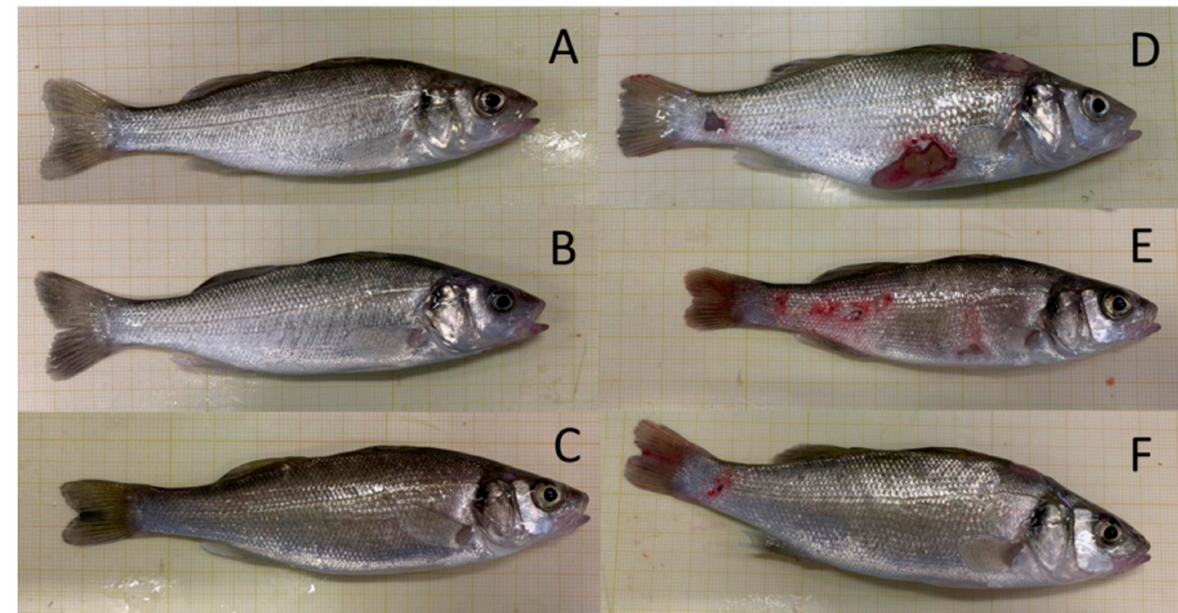
Figure 1. Macroscopic photographs of representative European sea bass specimens belonging to the non-infected ( A – C ) and infected group ( D – F ). Table 1. Bacterial strains isolated from European sea bass skin lesions and internal organs. MK, mid-kidney and HK,